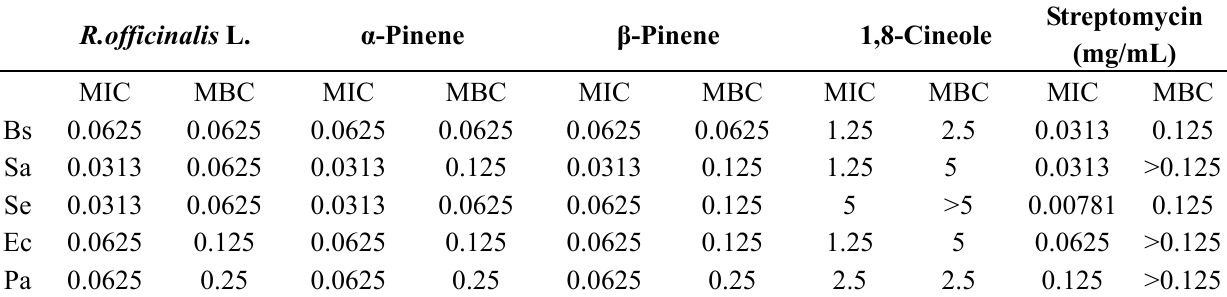
Table 1. Minimal inhibitory concentrations (MICs, % v/v) and minimal bactericidal concentrations (MBCs, % v/v) of Rosmarimus officinalis L. essential oil and three of its main components.